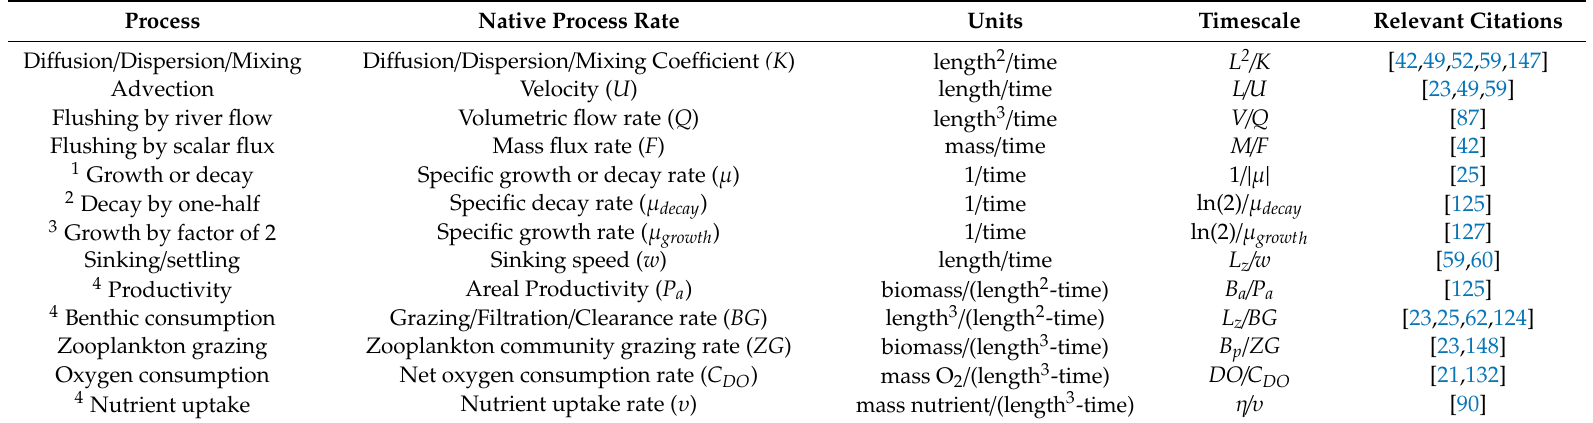
Table 1. Processes operating in aquatic systems, associated native process rates and their units, and common mathematical expressions for their corresponding timescales. Scales combined with process rates to construct timescales include: L (length), L z (vertical length), V (volume), M (integrated mass within a water body), B p (phytoplankton biomass concentration), B a (areal biomass concentration), DO (dissolved oxygen concentration), η (nutrient concentration). Specific growth or decay rate µ may be positive (growth) or negative (decay). Decay rate µ decay is assumed positive. Unless specified otherwise, concentrations here are assumed volumetric. Timescale expressions shown here may be adjusted if available parameters or units are di ff erent from those